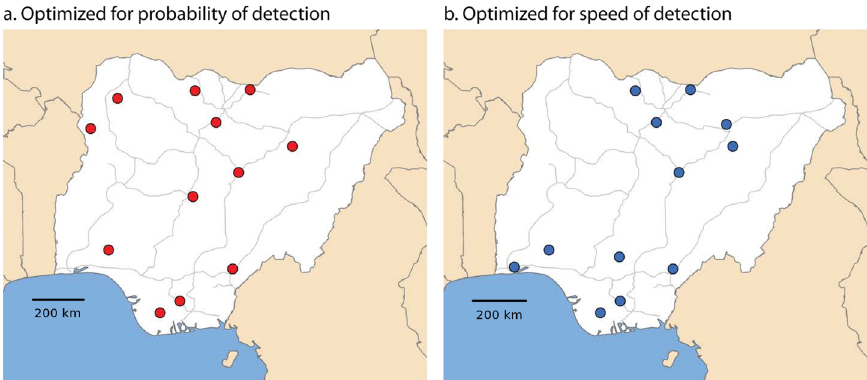
Fig 7. Surveillance architecture optimized for A) probability of detection, and B) speed of detection in Nigeria. When optimized for probability of detection, surveillance stations are dispersed throughout the country. When optimized for speed of detection, two groups surveillance stations form, one centered on the large population of animals in the north and one centered on the large population of animals in the